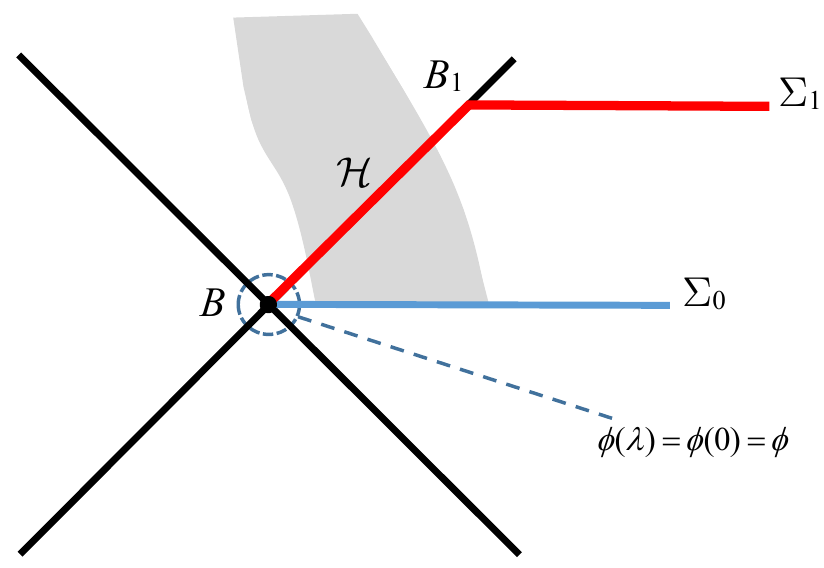
Figure 1 . Plot showing the perturbed geometry of the Kerr black hole and the choice of the hypersurface Σ = H ∪ Σ 1